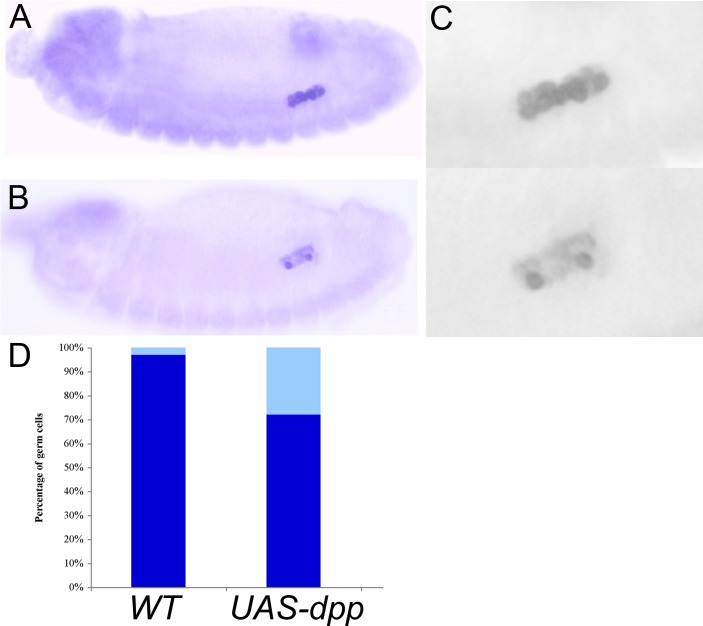
Effects of excess of BMP signaling on Vasa protein.
A. Stage 15 wild type embryo. Gonad is tightly coalesced and all germ cells stain strongly for Vasa. B. Stage 15 nos-Gal4/UAS-dpp embryo. Most germ cells stain in this embryo only faintly for Vasa. C. Blow-up grey scale image of Vasa accumulation in the PGCs shown in the embryos in panels A and B. Upper panel: WT PGCs. Lower panel: nos-Gal4/UAS-dpp PGCs. D. Vasa expression in WT, nos-Gal4/UAS-dpp and nos-Gal4/UAS-lwrDN stage 15 embryos. Embryos have a single copy of both the Gal4 driver and the UAS transgene as indicated. Dark blue: Percent of PGCs having normal levels of Vasa. Light blue: Percent of PGCs having an obvious reduction in the levels of Vasa compared to their sibs in the same embryo. For this analysis, Vasa levels were scored by comparing staining in the PGCs of the same embryo, not between different embryos. In a wild type embryo (processed in parallel) all PGCs have a similar and uniformly high level of Vasa protein. In contrast, when BMP signaling is upregulated, the level of Vasa protein in different PGCs in the same embryo can differ.